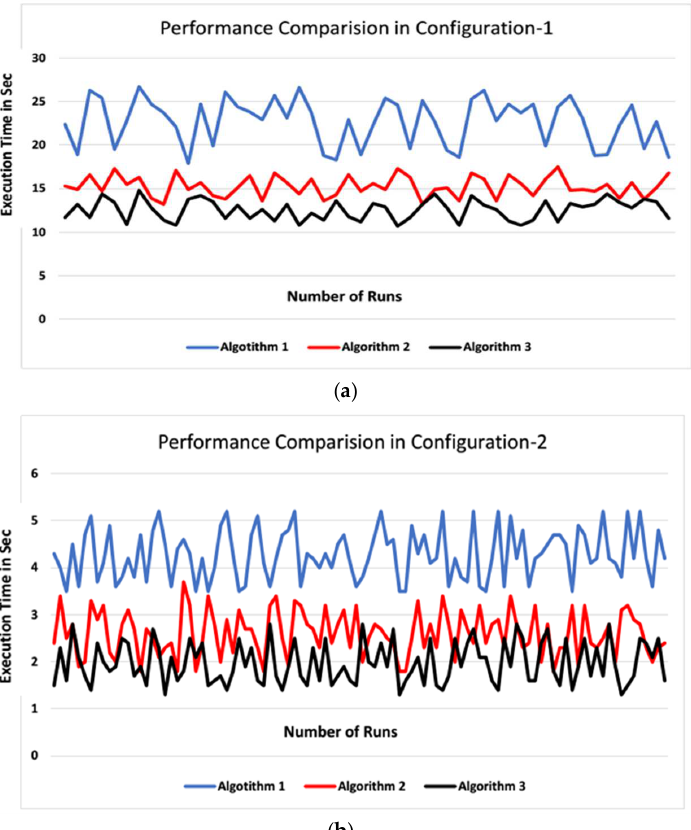
Figure 5. ( a ) Implementation of all 3 algorithms in configuration 1, ( b ) implementation of all 3 algorithms in configuration 2.